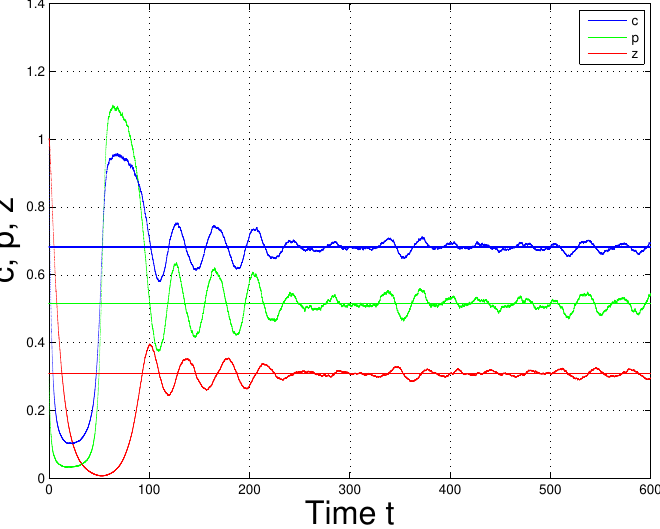
Figure 21. Persistence of system (12) when A = 1.8 and the remaining parameters stay unaltered as in Figure